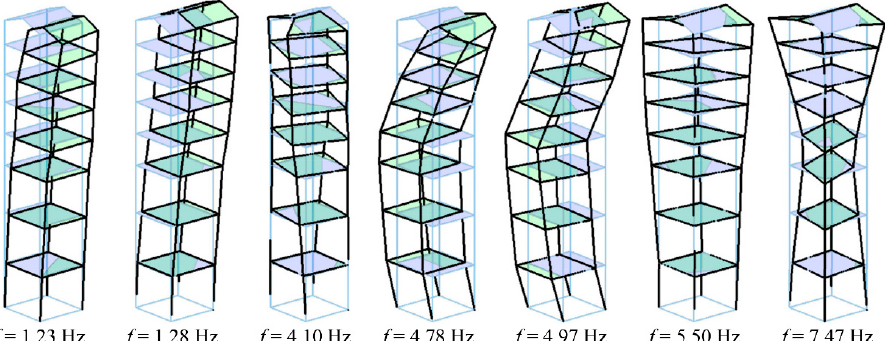
Figure 7. Zuccaro’s Tower in Mantua. The highest modes identified from ambient vibration measurements show warping distortion of the cross-sections ( f : frequency). In addition, most mode shapes seem to exhibit curvature change or increase around the 6th level, where the direct survey of the north–east side highlighted sharp discontinuities (Figure